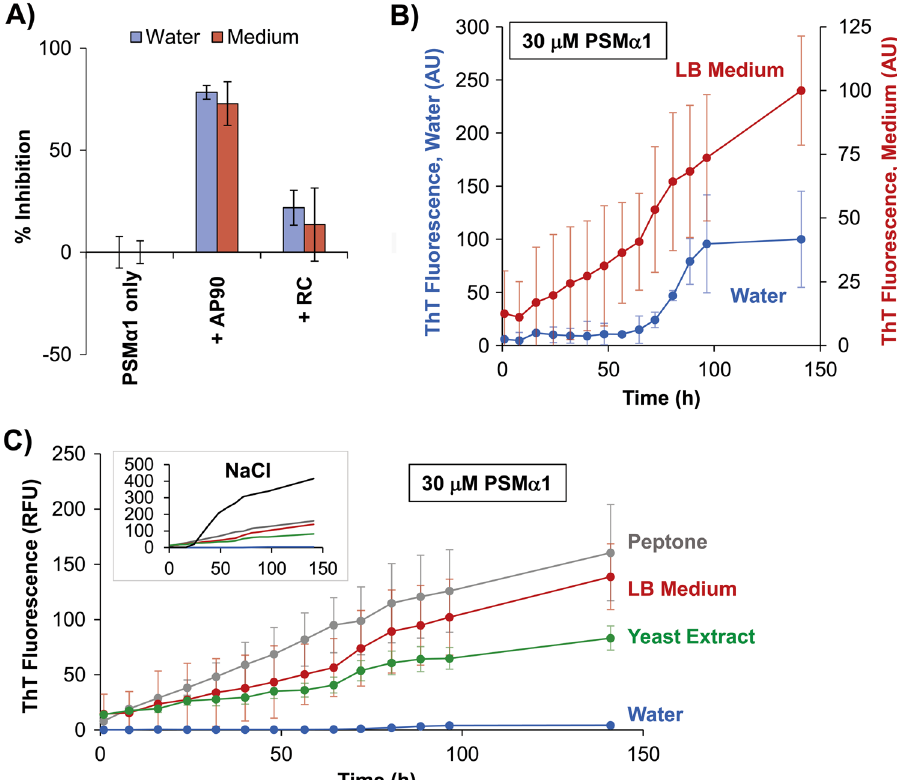
Fig. 5 Aggregation of synthetic PSM α 1 is inhibited by designed α -sheet peptides. a Synthetic PSM α 1 peptide (30 μ M, 0.34% DMSO, pH 5) was allowed to aggregate alone and in the presence of AP90 (1:4 molar ratio) and RC (1:4 molar ratio). Two different solvent conditions were used (0.34% DMSO in water, blue bars ; LB medium + 0.34% DMSO, red bars) and aggregation was monitored by ThT fl uorescence. Inhibition values for each peptide are reported as a percentage of the peptide-free control samples (0% inhibition). Error bars represent the standard error of the mean of 3 – 6 replicates. b ThT fl uorescence curves monitoring the aggregation kinetics of PSM α 1 under the two different solvent conditions in panel a (water = blue curve; LB medium = red curve). c The contribution of individual LB medium components (10 g/L peptone, 5 g/L yeast extract, and 85 mM NaCl) to PSM α 1 aggregation kinetics was also investigated. Fluorescence values in NaCl solution were quite high, so its curve is shown as an inset. All solutions contain 0.34% DMSO for consistency and solubilization of PSM α 1. Values in b and c are averages of 3 samples, corrected by relevant PSM α 1-free controls, with error bars to represent the standard deviation of the mean and curves are corrected by subtracting blanks lacking PSM α